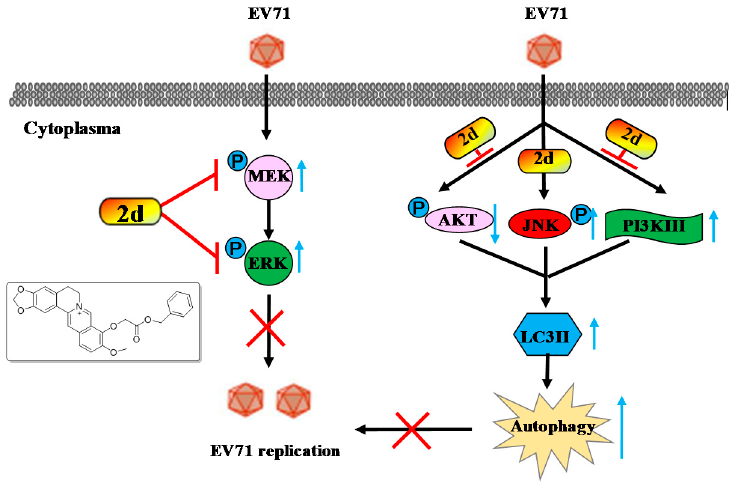
Figure 5. The cartoon chart of mechanism of compound 2d against EV71.